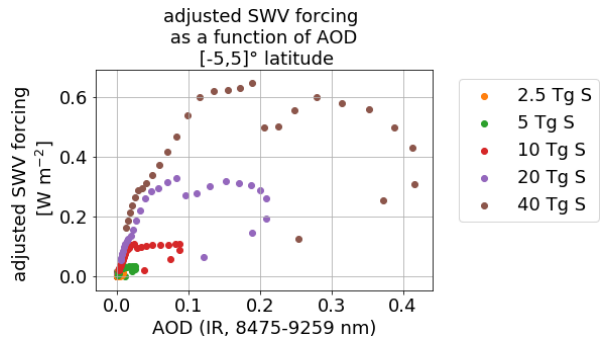
Figure A6. Scatter plot of AOD in the IR waveband (8475– 9250nm) and the clear-sky SWV forcing for all time steps in the first 2.5 years after the